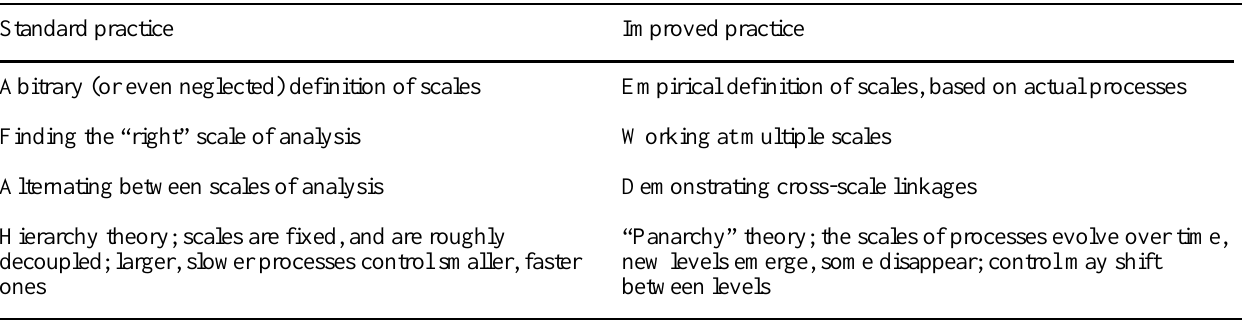
Table 1 . Scales and the problem of fit (adopted from Folke et al. 1998 a